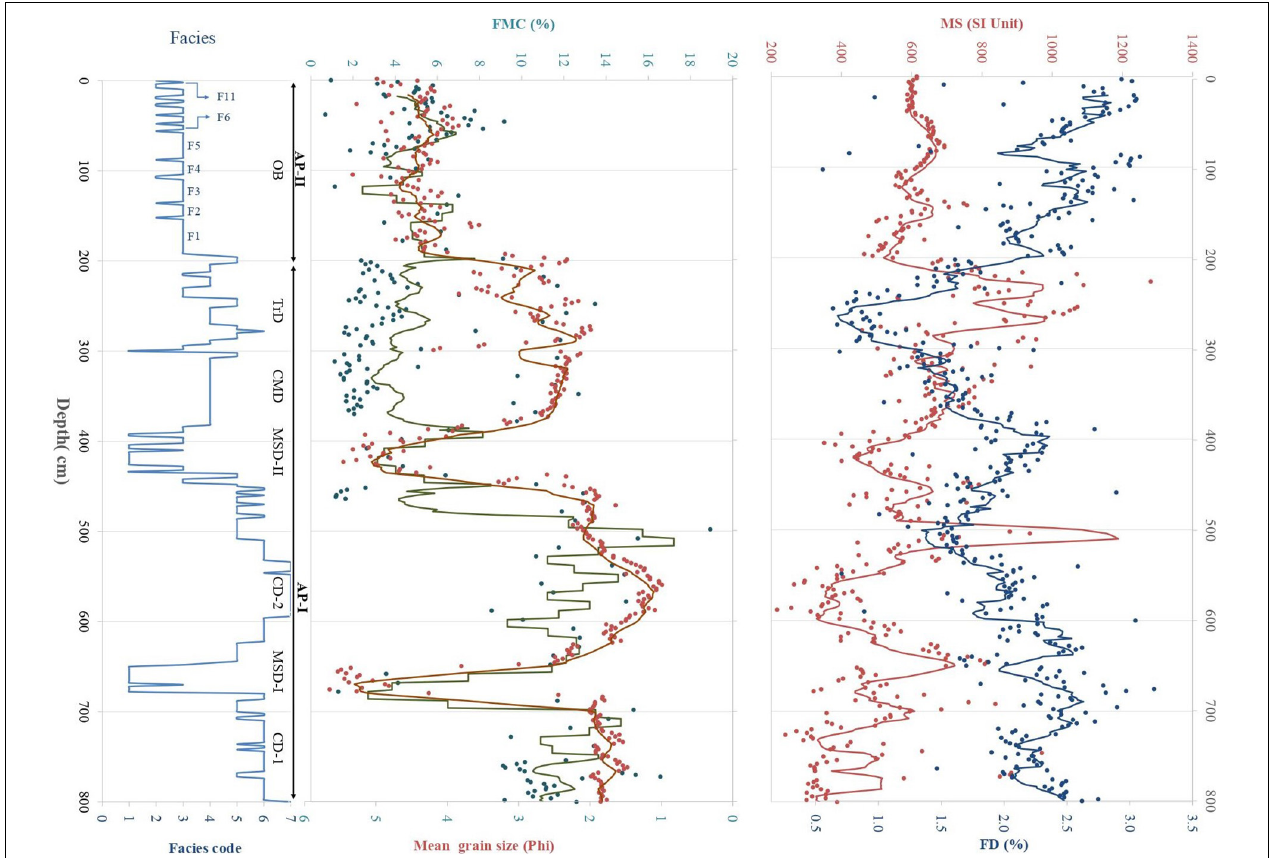
FIGURE 5 | Multi-proxy records of the Uchediya section showing depth-wise variation in sediment sub-facies, ferromagnetic mineral concentration (FMC%), mean grain size (Phi), magnetic susceptibility ( χ lf ) and frequency-dependent susceptibility ( χ FD%). The plots distinguish the Aggradation phase I and Aggradation phase II. Aggradation phase I further deciphers Channel Deposit (CD, couplets of 6 and 5 sub-facies and couplets of 6 and 7 sub-facies), Channel Margin Deposits (CMD, sub-facies 4), and Transition Deposit (TrD intercalation of 2, 3, 4, 5, and 6 sub-facies) from 802 to 194 cm. The two phases of monsoonal storms deposits (MSD, sub-facies 1) are conspicuous from 684 to 638 cm (MSD-I) and 450–376 cm (MSD-II) depth. Aggradation phase II highlights overbank deposits (OB, intercalation of 2 and 3 sub-facies) from 194 to 0 cm. F1–F11 indicate inferred flood